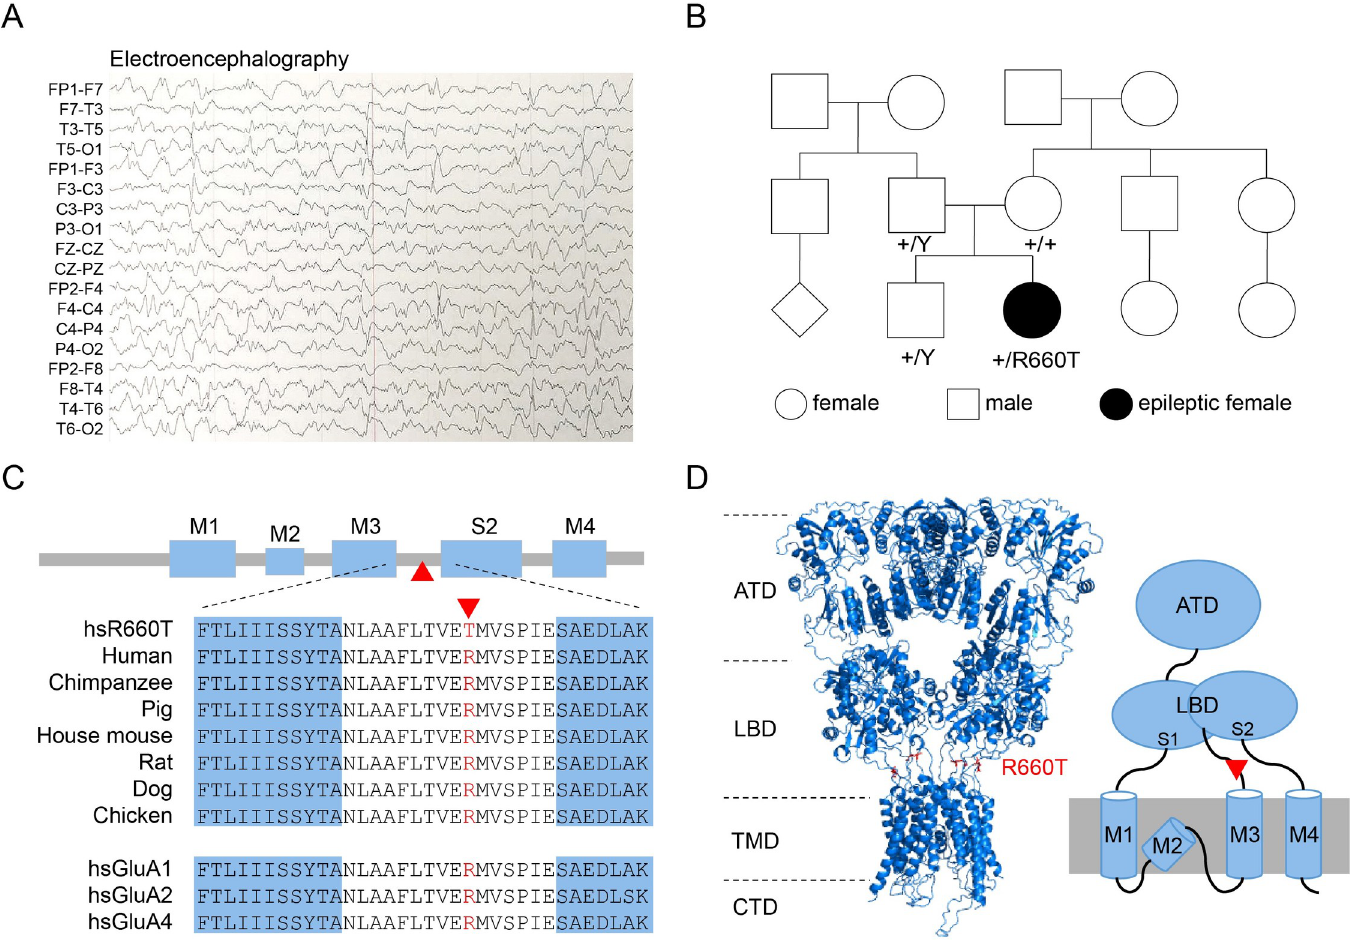
Fig 1. The patient and the variant in GRIA3 . (A) Electroencephalography of the proband showing typical epileptic waveforms. (B) Family pedigree showing a de novo GRIA3 variant (c.1979G > C, p.R660T) identified in the proband. The variant is absent in her parents and brother. (C) AMPA receptors architecture and sequence alignment. (D) A tertiary GLUA3 homomeric model (left) constructed from the GluA2 structure (PDB ID: 5WEO) and a schematic depict of a single GluA3 subunit (right) indicate the location of the mutant host